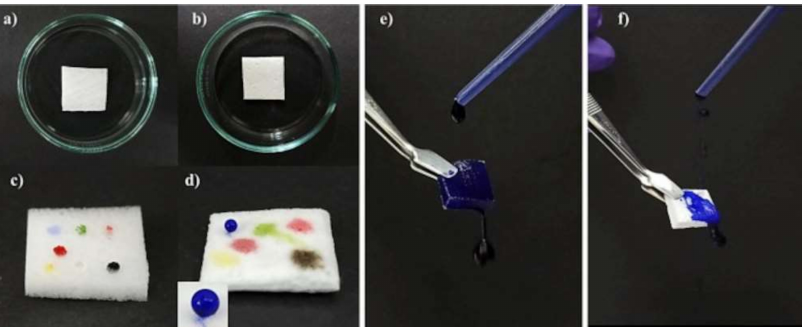
Figure 5. ( a ) Pristine melamine (PM), ( b ) PCL/PDLLA (80:20) melamine sorbent, oil and water absorption of ( c ) pristine melamine and ( d ) PCL/PDLLA (80:20) (bluewater, red-hexane, maroon- octane, dark yellow-soybean oil, light yellow-motor oil, green-petroleum ether, and black crude oil). Water absorption of ( e ) pristine melamine and ( f ) PCL/PDLLA (80:20). Obtained from reference